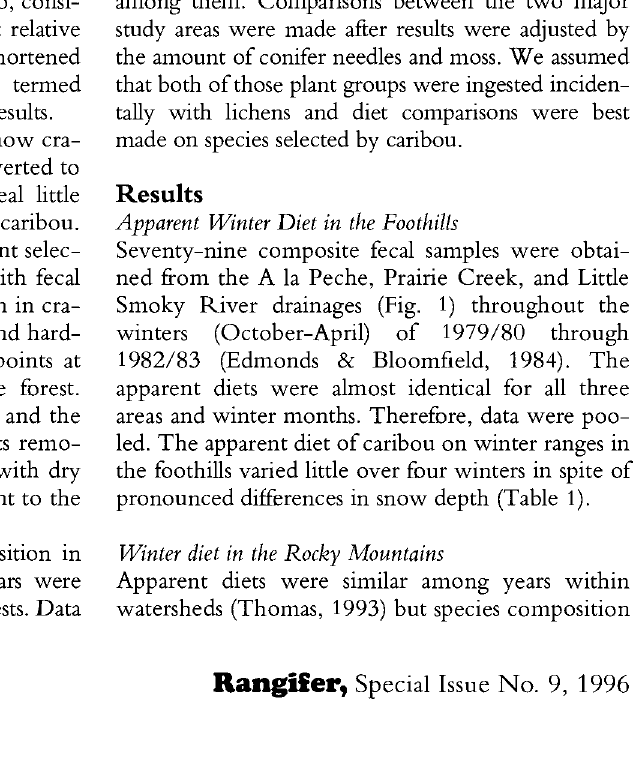
Fig. 1. Locations where fecal samples were obtained for this study of caribou diet.